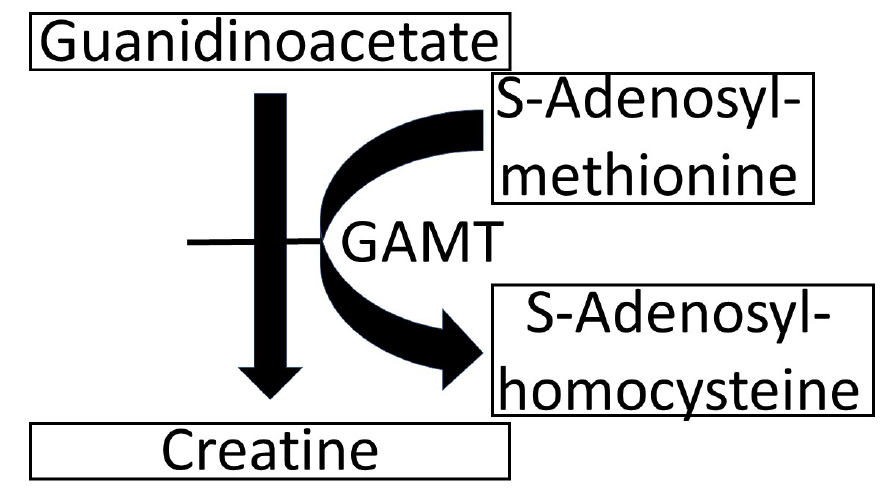
Figure 1. Synthesis of creatine from guanidinoacetate, catalyzed by the enzyme GuanidinoAcetate Methyl Transferase (GAMT).